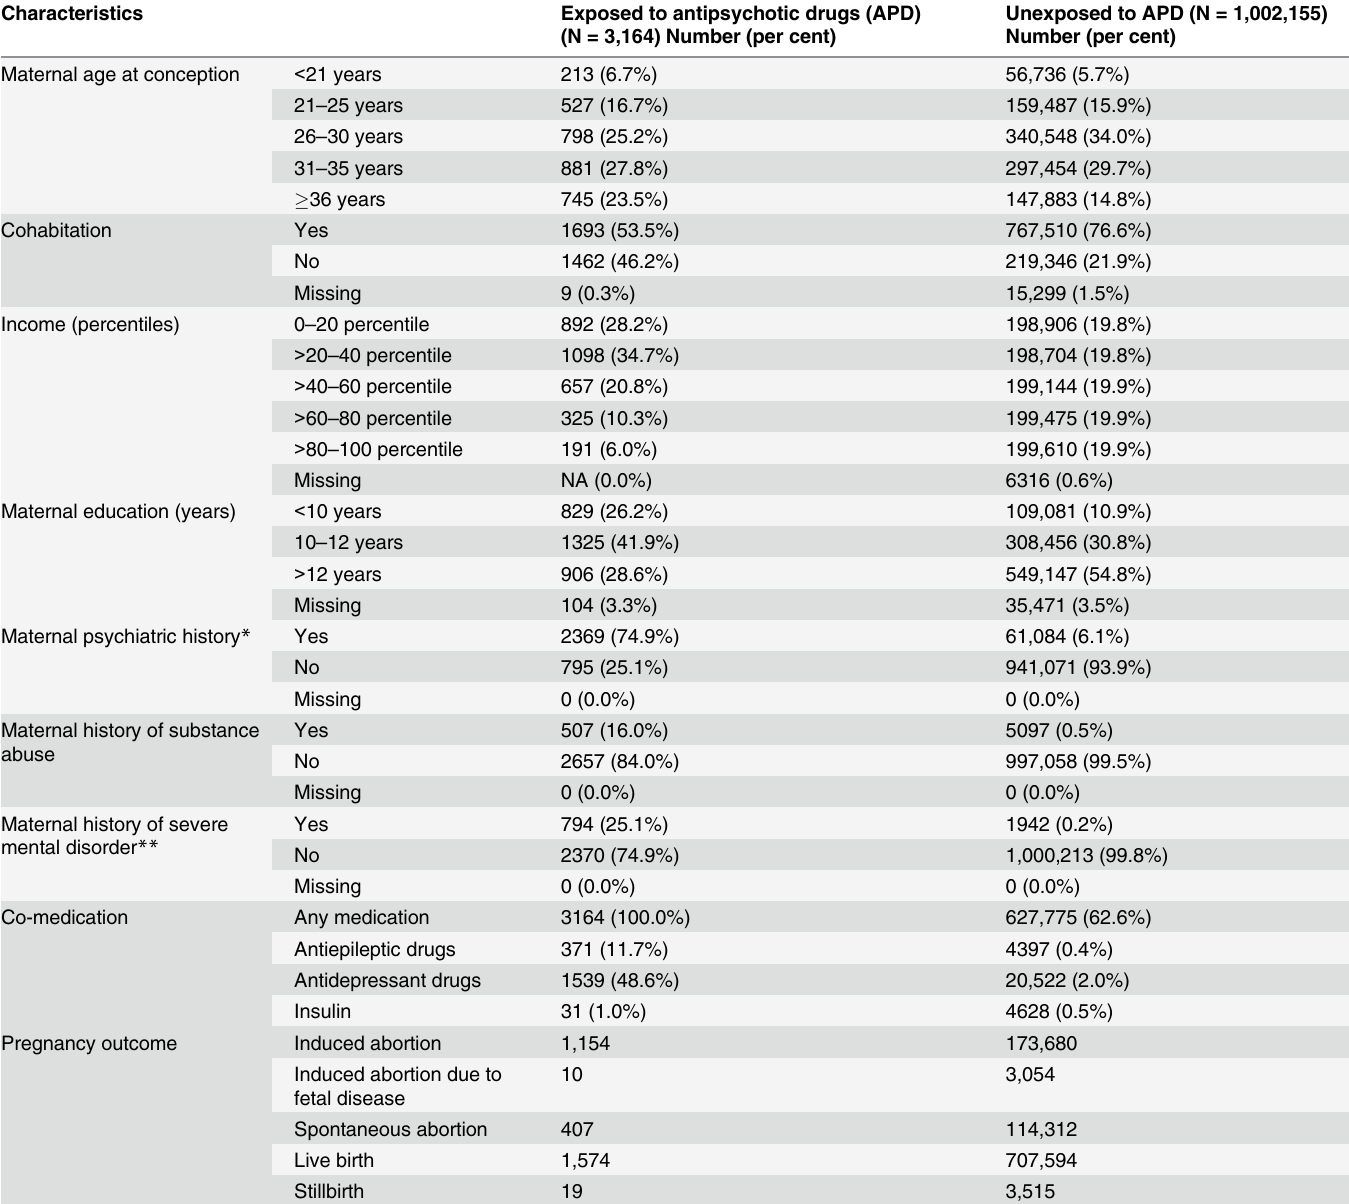
Table 1. Characteristics of study participants (numbers refer to pregnancies studied).